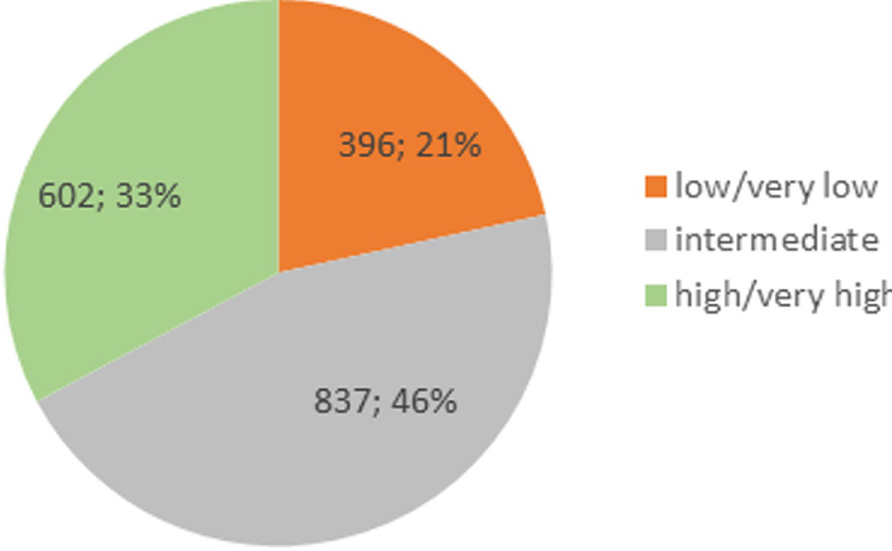
Fig 10. Estimated fitness level. ( N = 1835).